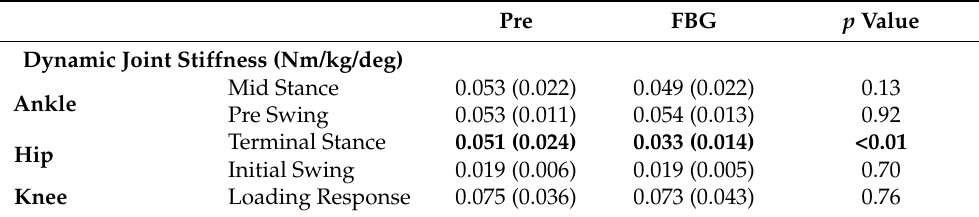
Table 6. Dynamic joint stiffness for pre and post wearing of FBG. Post wearing of the FBG had significantly decrease dynamic joint stiffness values in the Terminal stance when compared to the pre